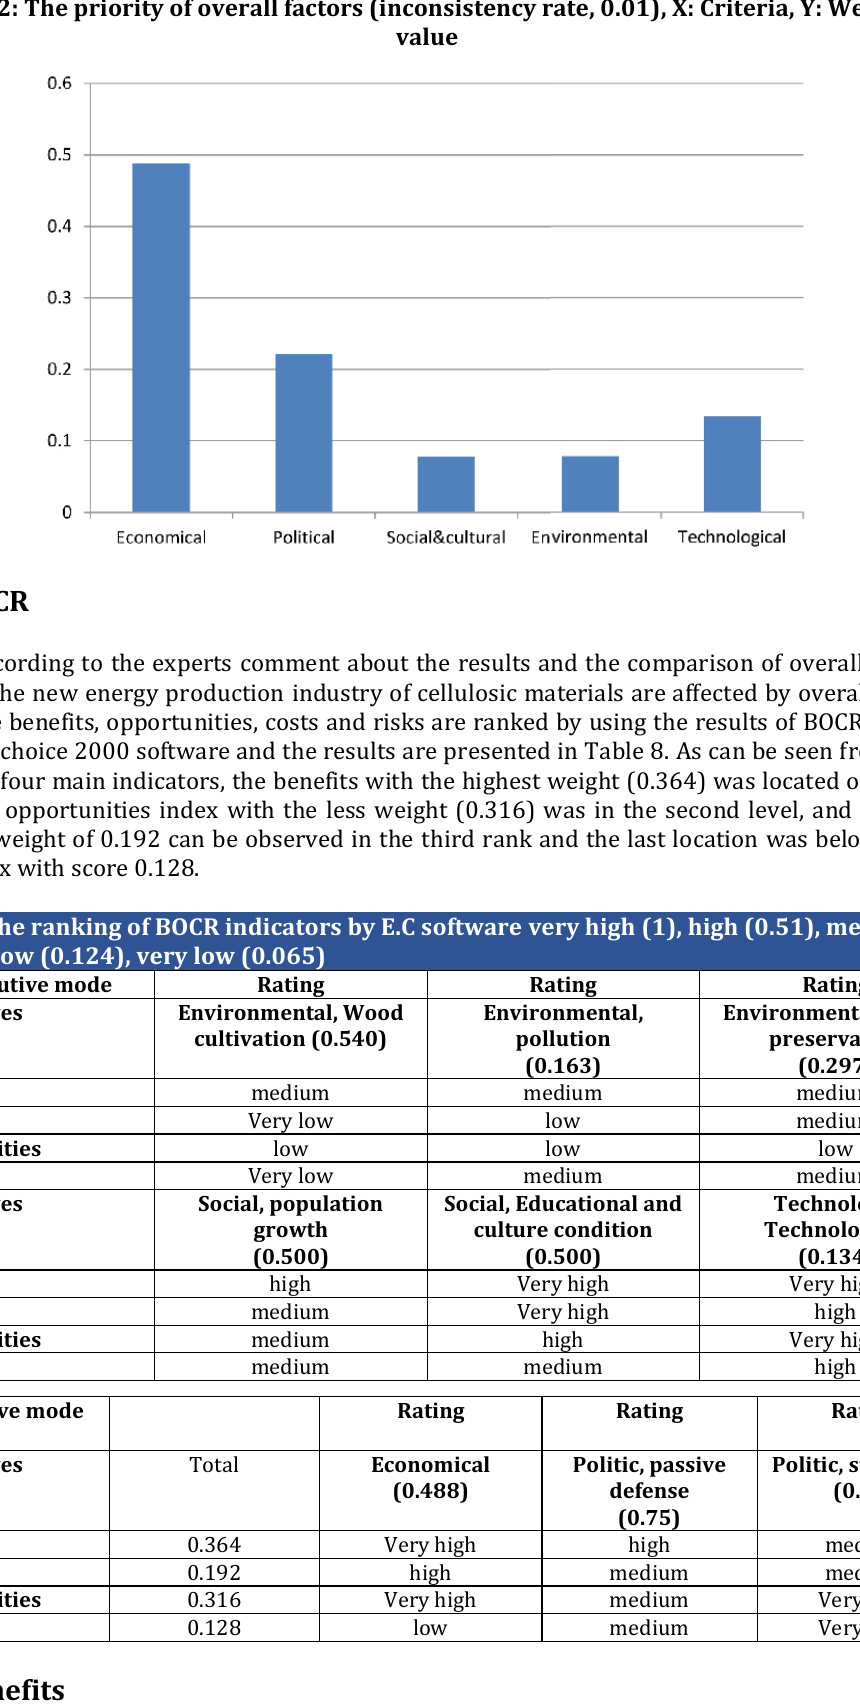
Figure 2: The priority of overall factors (inconsistency rate, 0.01), X: Criteria, Y: Weighing